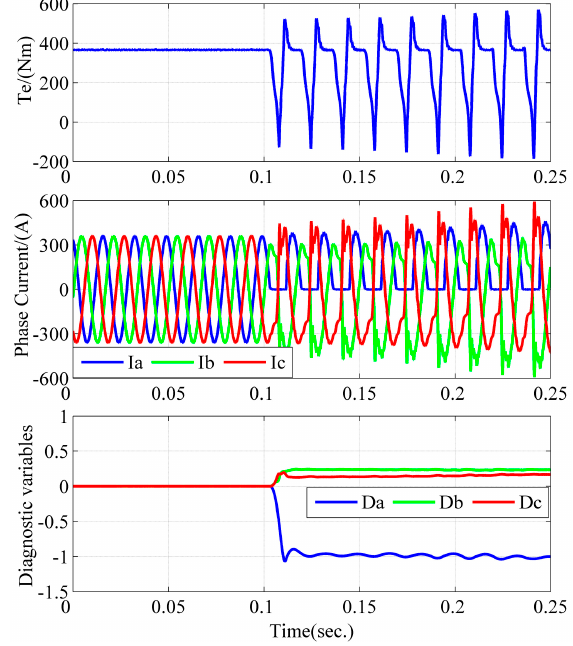
Figure 10. Diagnostic results at 600 rpm/358 Nm.